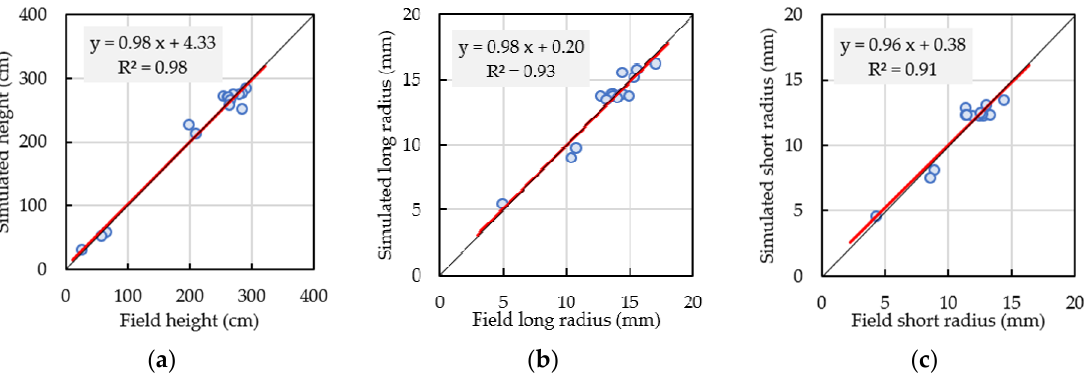
Figure 4. The results of the simulated values of the geometric parameters of the maize canopy compared with the field-measured values of the ( a ) maize height, ( b ) long radius, and ( c ) short radius. Table 3. The indicators of the simulated maize height and stem radius in the maize canopy param- eters compared to the field-measured values.